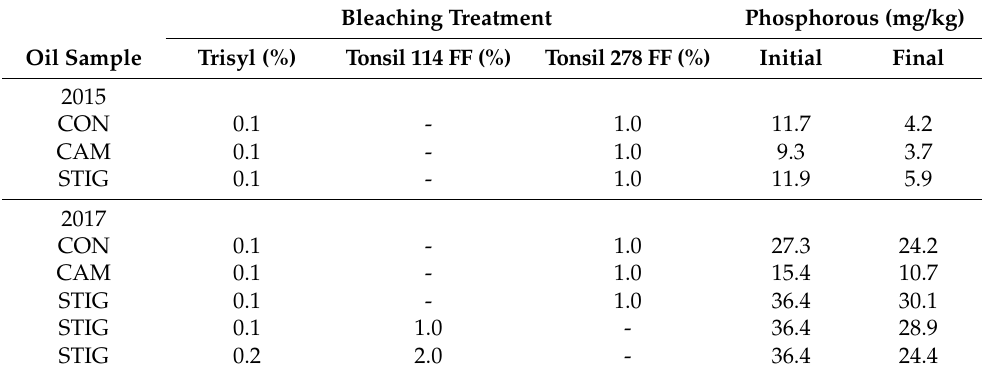
Table 2. Phosphorous content (mg kg − 1 ) in the press oil samples after